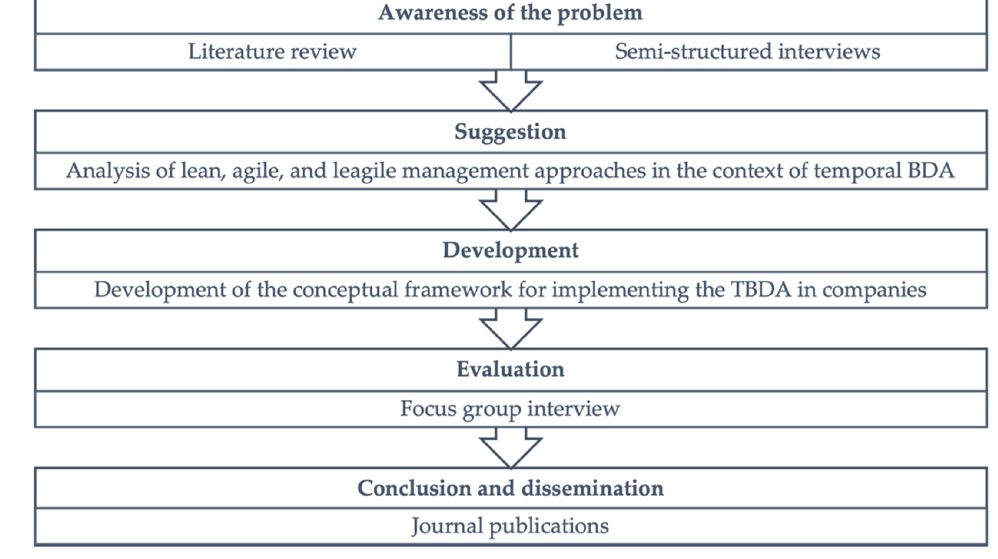
Figure 1. The general sequence of research steps using the DSRIS methodology.